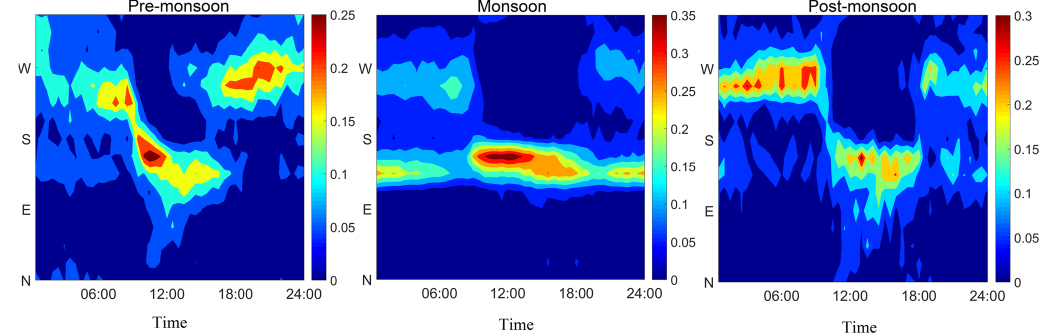
Figure 4. The average diurnal pattern of frequency distribution of wind direction during pre-monsoon, monsoon and post-monsoon periods from 2012 to 2015.